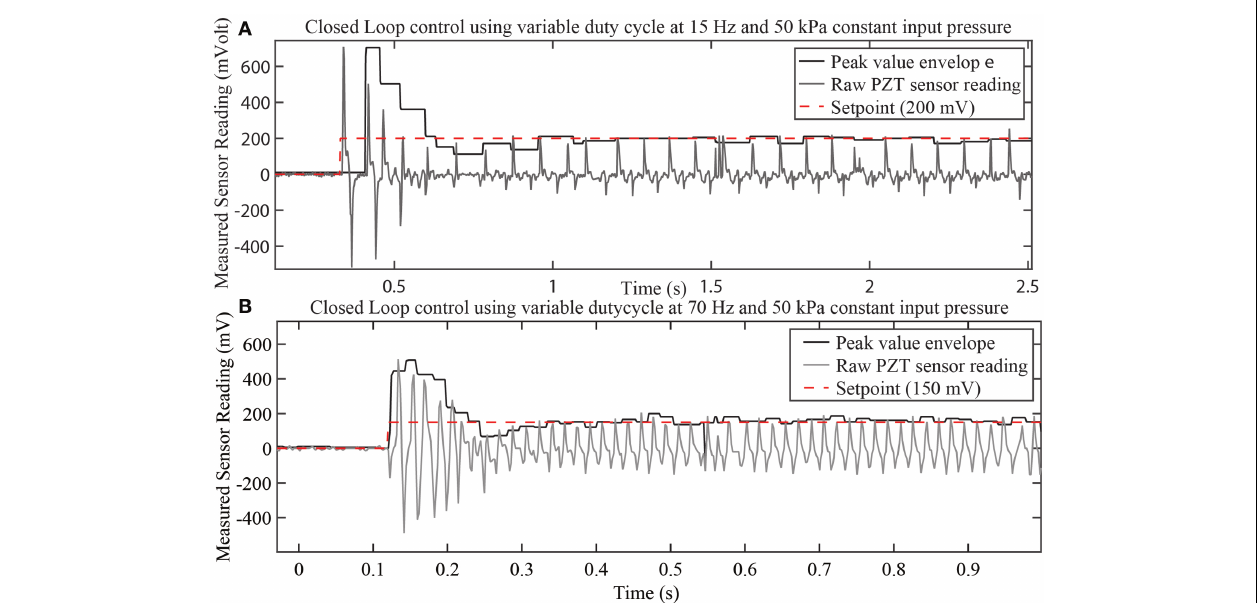
FIGURE 8 | Closed-loop control results for the PI-controller . The SPA skin is actuated at 15Hz (A) and 70Hz (B) at a constant regulator pressure of 50kPa to validate the controller performance over range of actuation frequencies. The peak value envelope signal derived from the raw PZT sensor reading acts as a control signal to generate the desired duty cycle for the pneumatic valve.